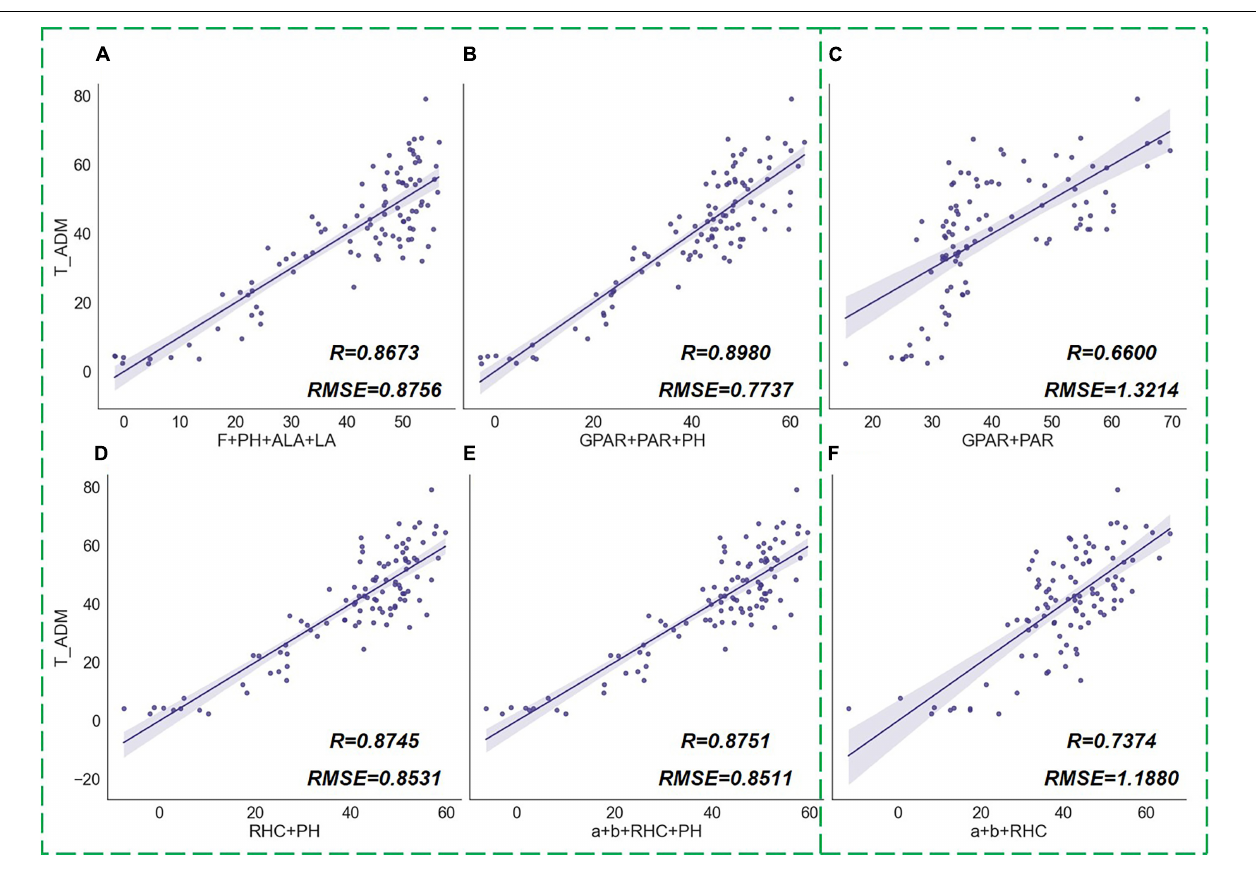
FIGURE 14 | MLR results of phenotypic traits groups and above-ground dry matter of rice ( ADM ). The scatter graphs show the Pearson correlation test results between the regression values and the true measurement values. The x -axis represents the ADM values derived from the regression model, and the y -axis represents the measured ADM values. Different combinations of traits are (A) [ F , PH , ALA , LA ], (B) [ GPAR , PAR , PH ], (C) [ GPAR , PAR ], (D) [ RHC , PH ], (E) [ a , b , RHC , PH ], (F) [ a , b , RHC ].